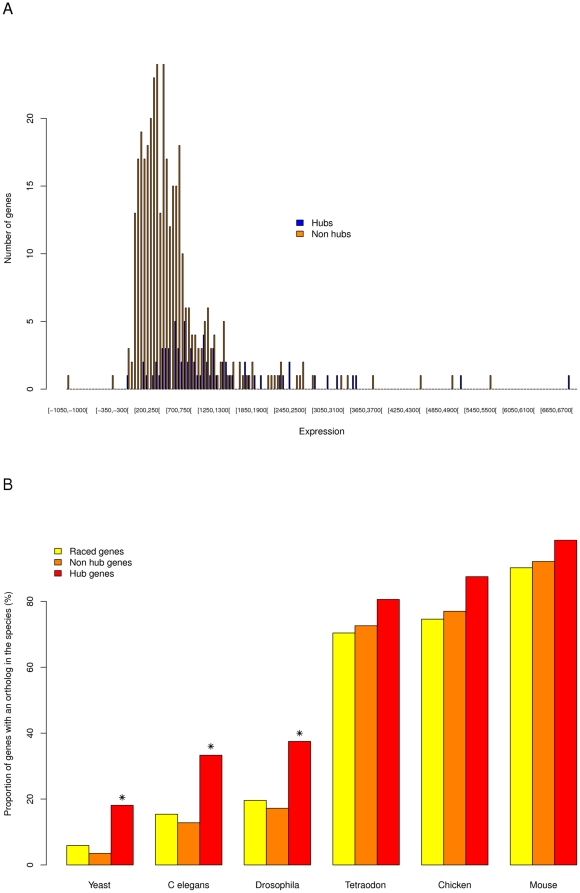
Characteristics of hub genes. A- Expression of hub genes.The distribution of expression of the 74 hubs and of the 362 non hubs is plotted in blue and orange respectively. The expression of a gene is computed based on tiling array experiments performed on the same 16 cell lines and tissues as the RACE experiments (see details in the text). As we can see hubs tend to have higher expression values than non hubs. B-
Phylogenetic conservation of hub genes. In each of the three gene network categories (i.e., hubs, non-hubs, and all RACEd genes), the proportion of genes having a detected ortholog in each eukaryotic species represented on the X axis (ordered by decreasing phylogenetic distance from human) is reported on the Y axis. Instances where the proportion of orthologs found in the hub category is significantly higher than for non-hubs (p<0.01, Fisher test) are marked with an asterisk.